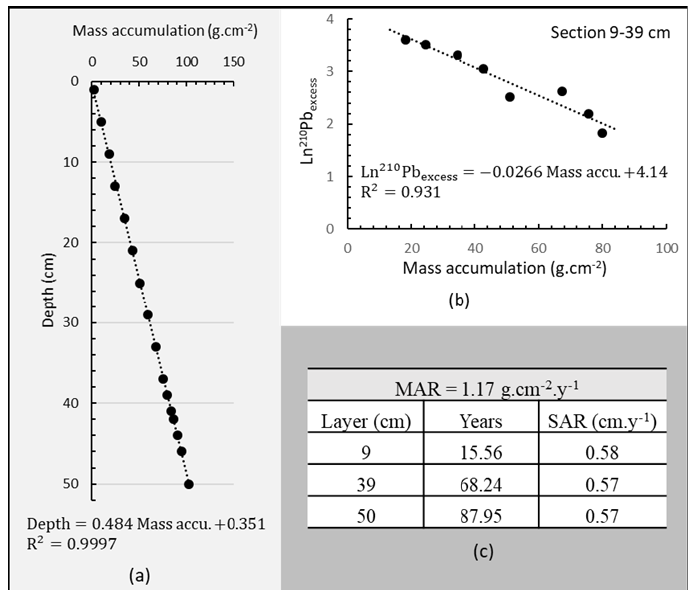
Figure 9. ( a ) Mass accumulation profile in the entire core, ( b ) ln 210 Pb excess plotted against the mass accumulation in the Section 9 – 39 cm, and ( c ) calculated SAR in each core